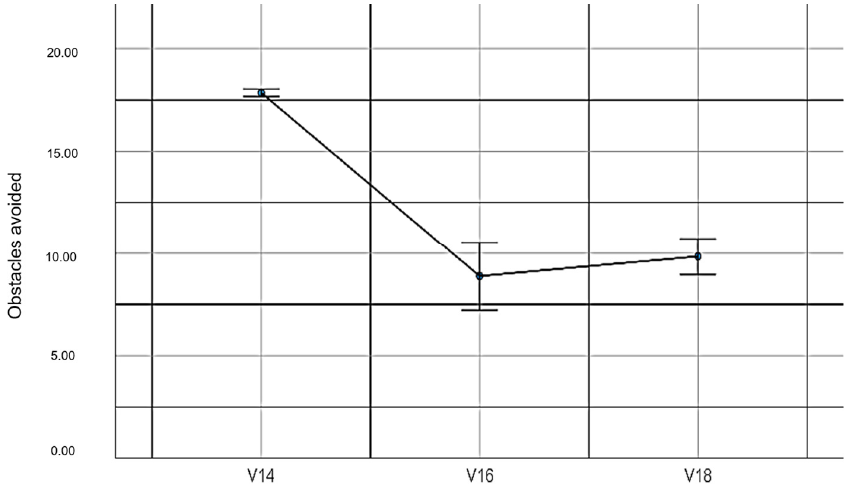
Figure 13. Number of obstacles evaded.